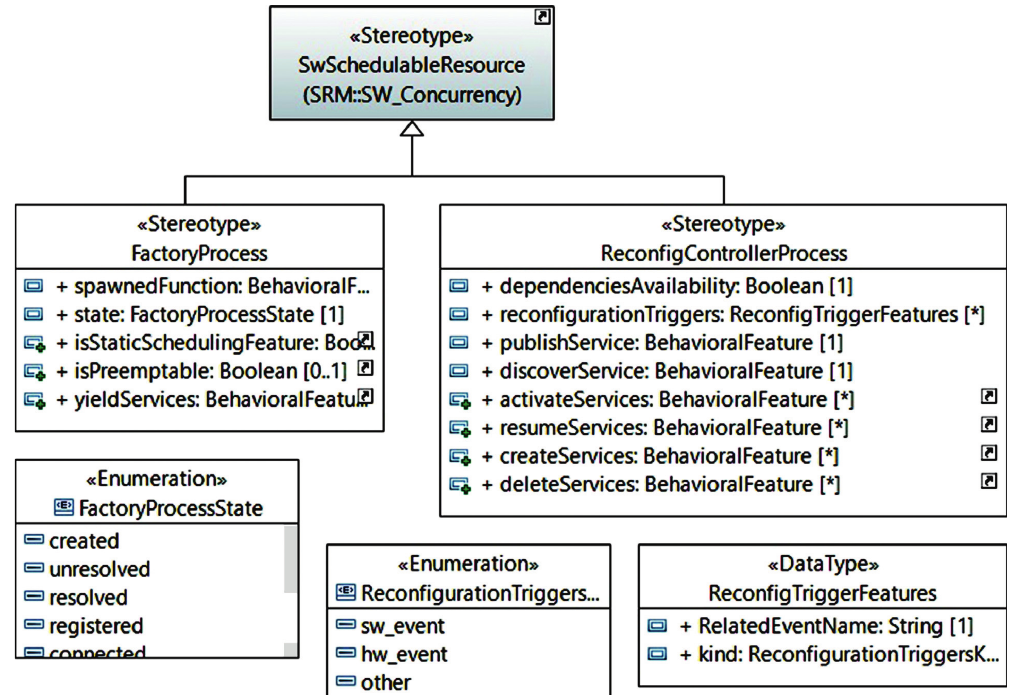
Figure 9: Extended SRM